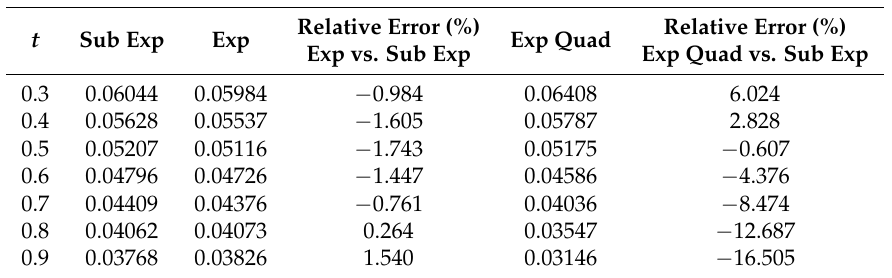
ranges from 0.3–0.9 years. β 1 = β 2 =